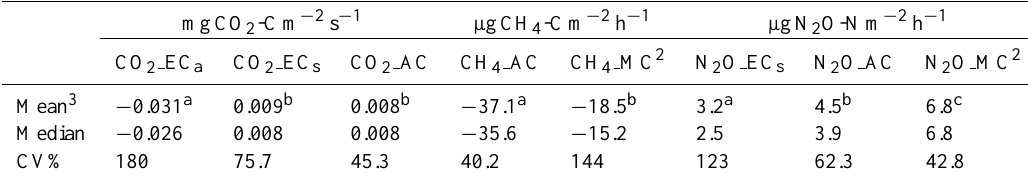
Table 1. Mean and median fluxes of CO 2 , CH 4 and N 2 O and coefficient of variation (CV% 1 ) measured by eddy covariance, and automatic and manual chambers in Kalevansuo peatland forest during 25 April–27 June 2007. EC a and EC s stand for eddy covariance above and below the canopy, respectively, and AC and MC stand for automatic and manual chambers, respectively.